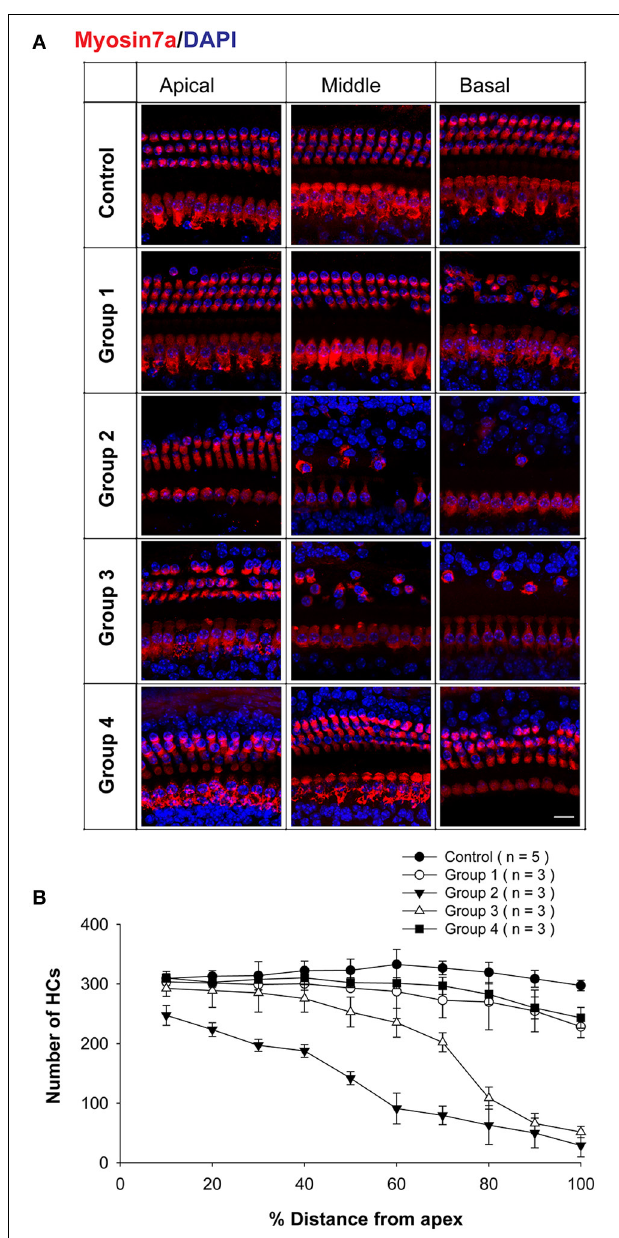
FIGURE 2 | HC loss in neomycin-treated WT mice. (A) Representative confocal images of myo7a immunofluorescence in cochlear whole mounts of WT mice treated with neomycin or saline (control) once daily between P1 and P7 (Group 1), P8 and P14 (Group 2), P15 and P21 (Group 3), or P60 and P66 (Group 4) and sacrificed 2 weeks after the last injection of neomycin or saline. (B) Myo7a + HC quantification in WT mice treated with neomycin or saline (control) and sacrificed 2 weeks after the last injection of neomycin or saline. Scale Bar in A = 10 μ m.